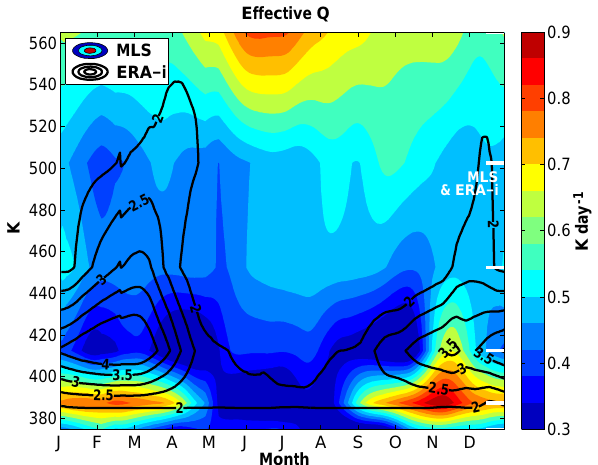
Figure 8. The effective vertical transport velocities in isentropic coordinates (effective diabatic heating rate; Kday − 1 ) based on the phase-lagged correlation method. The colors indicate the MLS ob- servations, and the black contours indicate the ERA-i reanalysis (note the different magnitude). The midpoint levels used for lag cor- relations are indicated as white bars on the right (same for MLS and